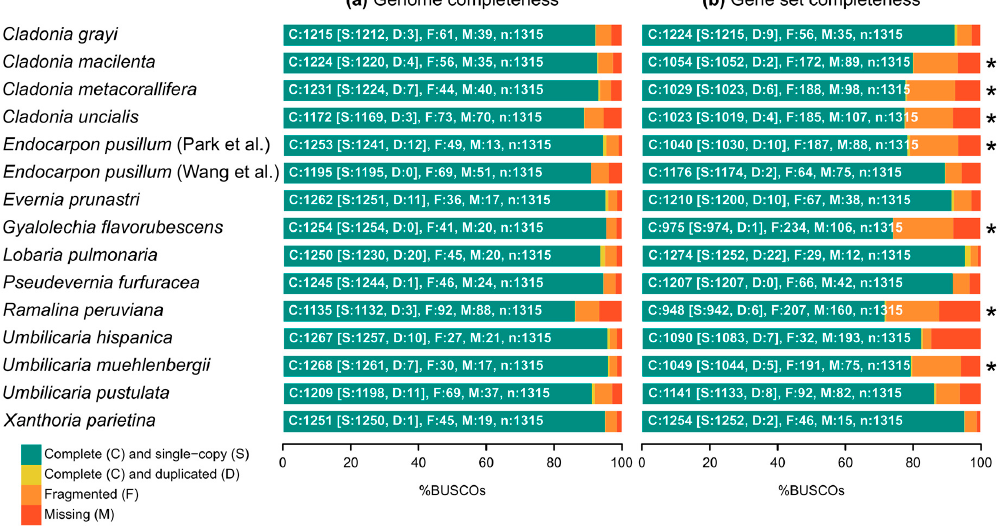
Figure 1. ( a ) Genome completeness for assemblies and ( b ) gene set completeness for gene